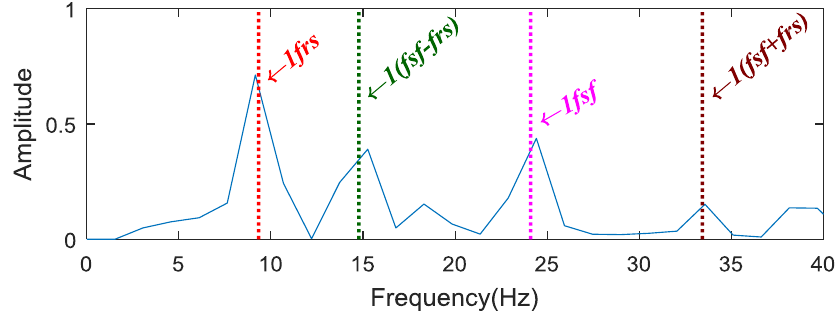
Figure 8. Results of the proposed method.